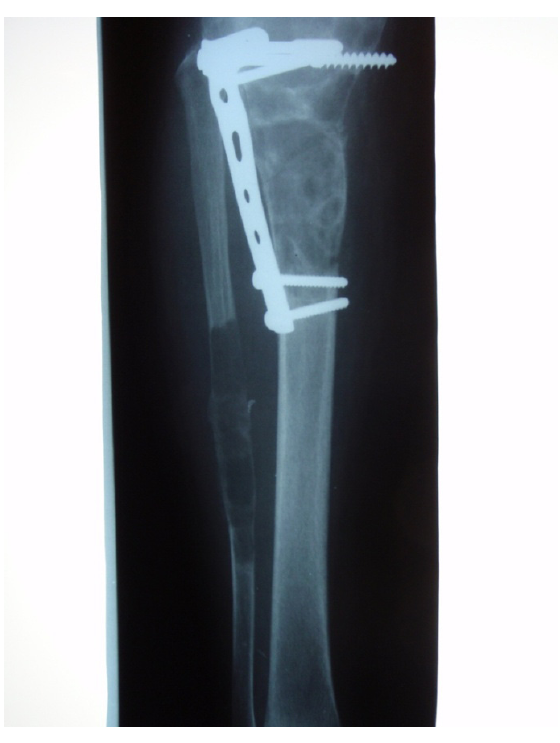
Figure 2. Pathological bone fracture due to tibia and fibula cystic fibrosis.